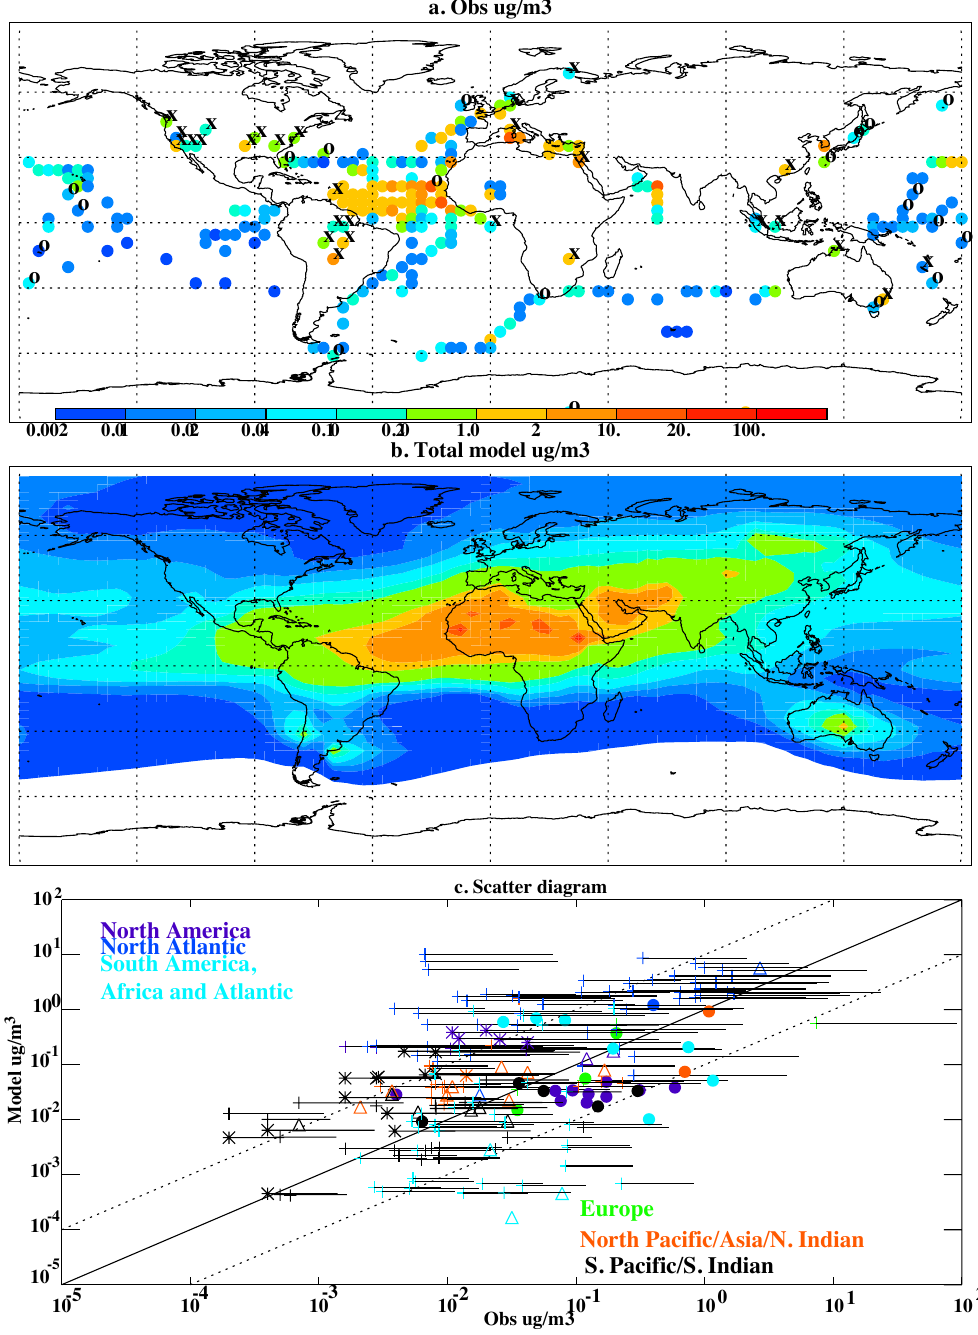
Fig. A1. Annual atmospheric surface iron concentration measurements (a) compared to model estimates (based on 3.5% iron in desert dust) (b) , and shown in scatterplot format (c) . The data compilation comes from (Mahowald et al., 2009). The horizontal lines represent the uncertainties in the model because the observations are taken from cruises, and include only 1–2 days, while the model shows annual averages (described in more detail in Mahowald et al.,